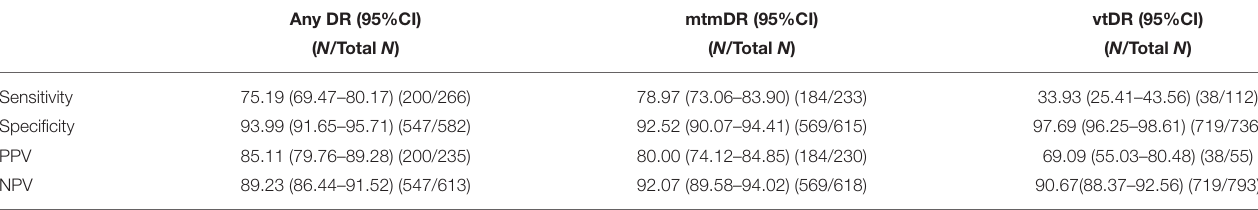
TABLE 2 | CARE performance for detecting DR.